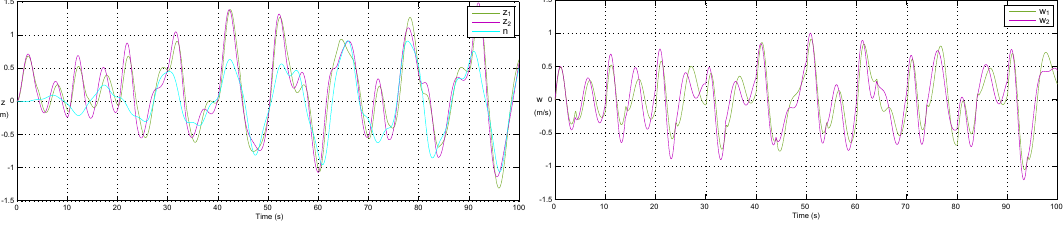
Figure 3. Comparison of models: complete ( z 1, w 1) vs. simplified ( z 2, w 2). The height of the wave is n